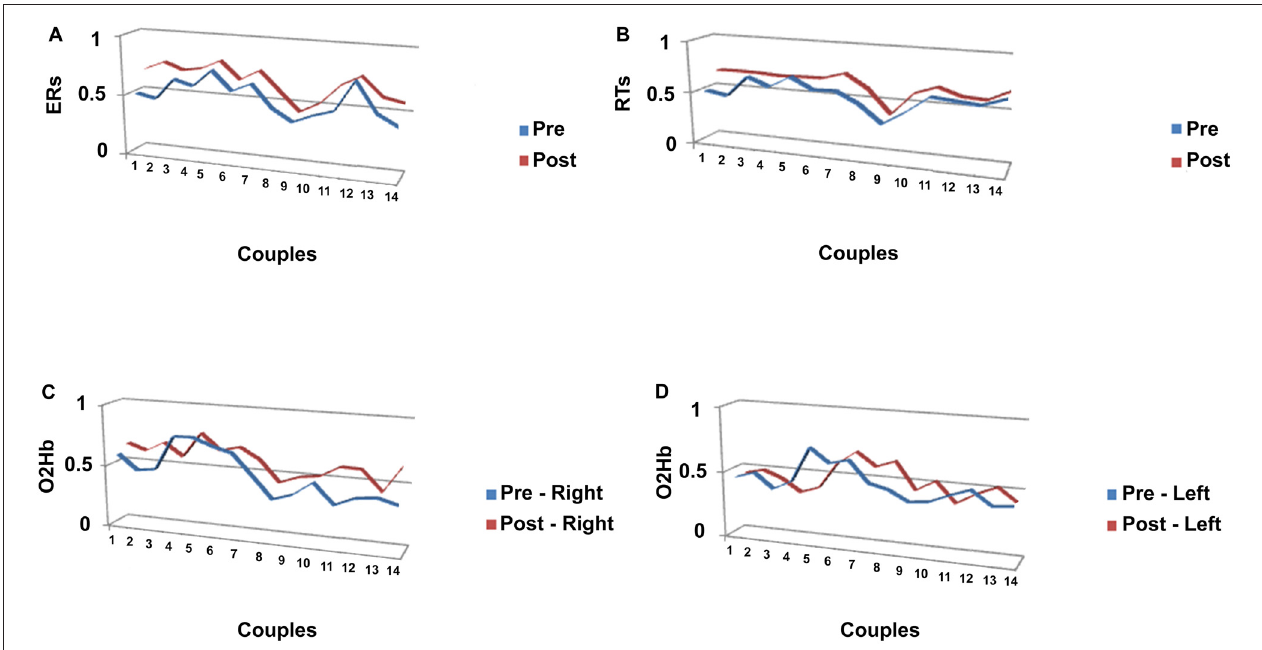
FIGURE 4 | Similarity measures (Pearson coefficients) for couples of subjects for (A) ERs; (B) RTs, a function of pre-feedback and post-feedback; (C) O2Hb variable as a function of right (C) and left (D) hemisphere.